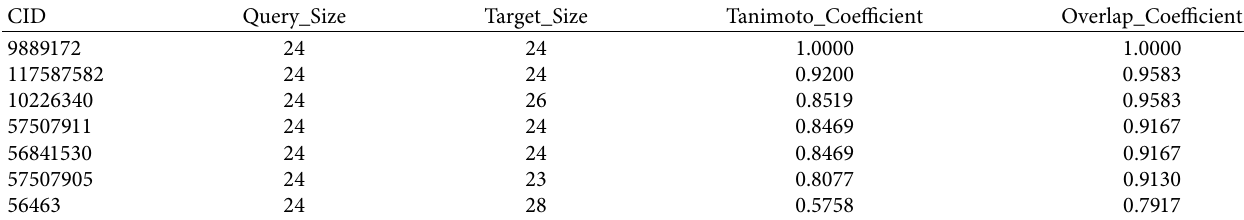
Table 4: Similarity measures for the molecule CID 9889172 and the molecules in Group 1.